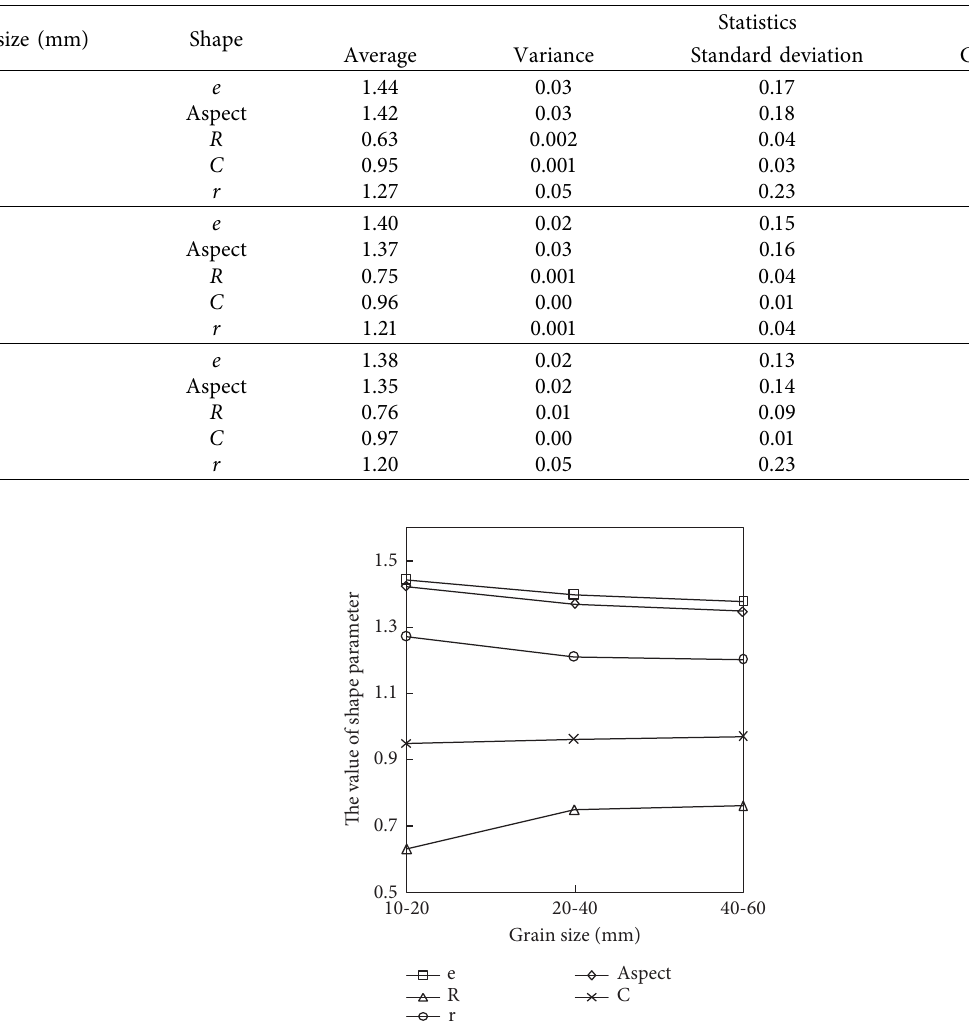
Figure 5: Simon shape classifcation diagram of limestone particles. Table 2: Statistics of limestone particle shape parameters.